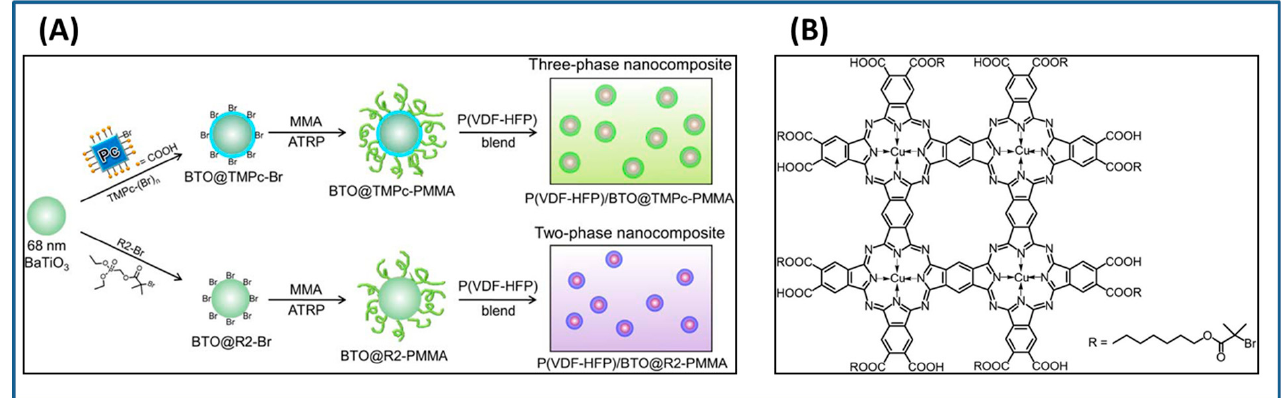
Figure 8. ( A ) Schematic illustration of the preparation of three- and two-phase P(VDF-HFP)/BaTiO 3 nanocomposites, respectively; ( B ) Chemical structure of the TMPc-Br ATRP initiator. Reproduced with permission from Ref [124].